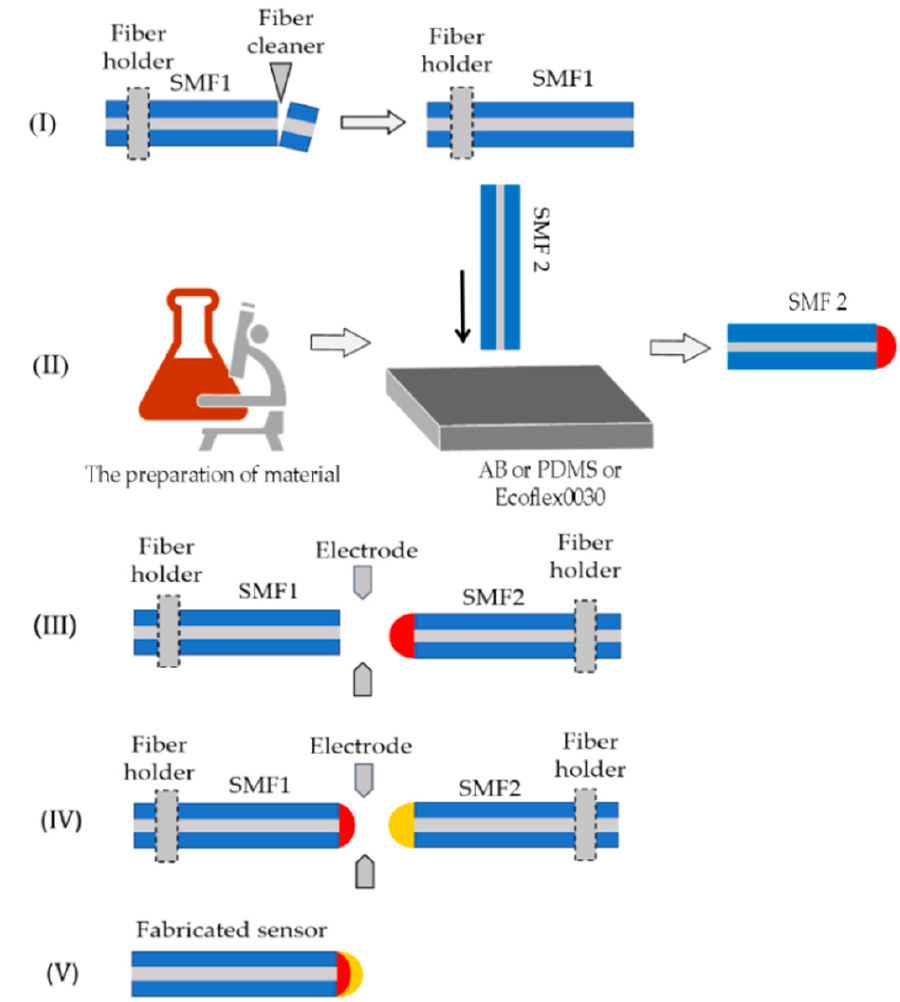
Figure 3. The preparation process of the composite structure based on dual FP cavities. Figure 4a,c demonstrate the interference spectra of a single-cavity structure and a dual-cavity structure ( S 1 ) based on the three-beam interference principle. Figure 4a,c can only display the interference spectrum within the range of 1525–1610 nm due to the limited bandwidth of ASE light source. The free spectrum ranges of the sensors are 53 and 27 nm, respectively, owing to the difference of cavity length and refractive index. Simultaneously, different FP cavities have different contributions to the reflected intensity. This can be demonstrated by the fast Fourier transform (FFT) of the total reflected spectrum of the sensor. As shown in Figure 4d, there are two particularly distinct frequency peaks, labeled Peak 1 (0.03525 nm − 1 ) and Peak 2 (0.05875 nm − 1